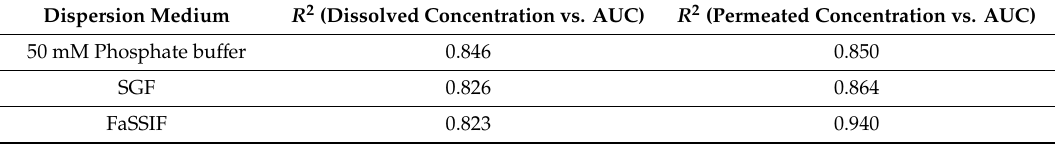
Table 3. Coe ffi cient of determination when plotting the dissolved tadalafil concentration or the permeated tadalafil concentration (i.e., concentration in donor or acceptor compartment) for experiments using di ff erent dispersion media after 6 h of incubation against in vivo AUC from [26]. Dispersion Medium R 2 (Dissolved Concentration vs.